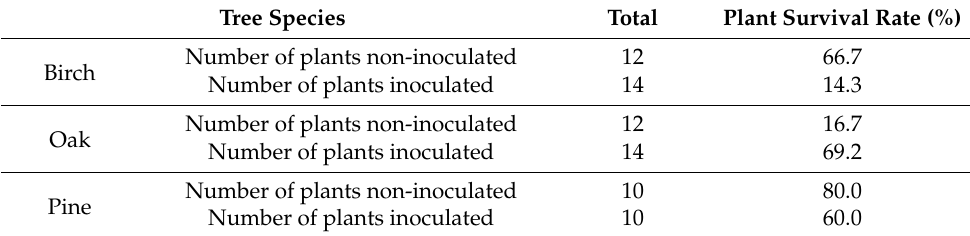
Table 6. Pot plant’s survival